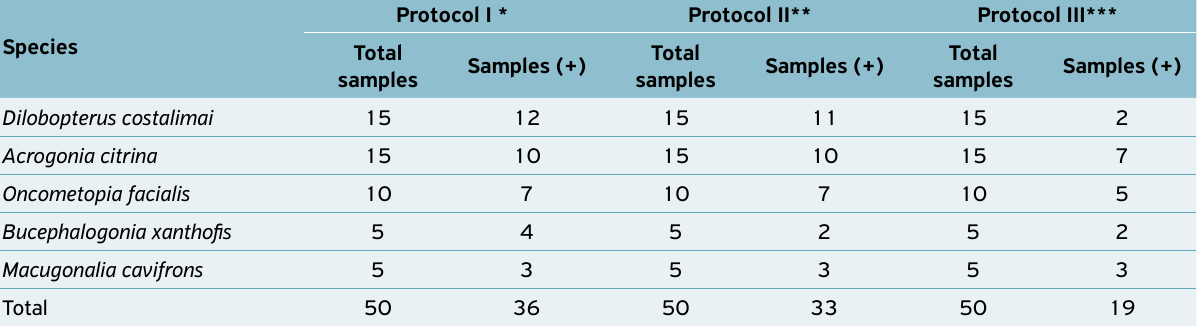
Table 1. Comparison among DNA extraction methods for the detection of X. fastidiosa bacteria in sweet orange using nested‑PCR.